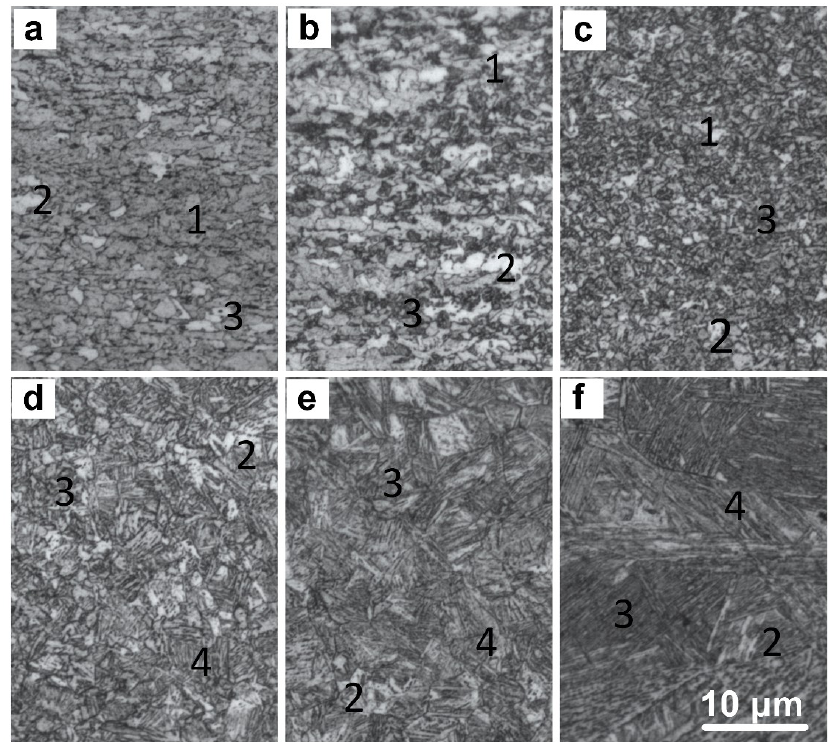
Figure 6. Optical images of the microstructures in the X100 laser-welded joint (1-AF, 2-GB, 3-MA,